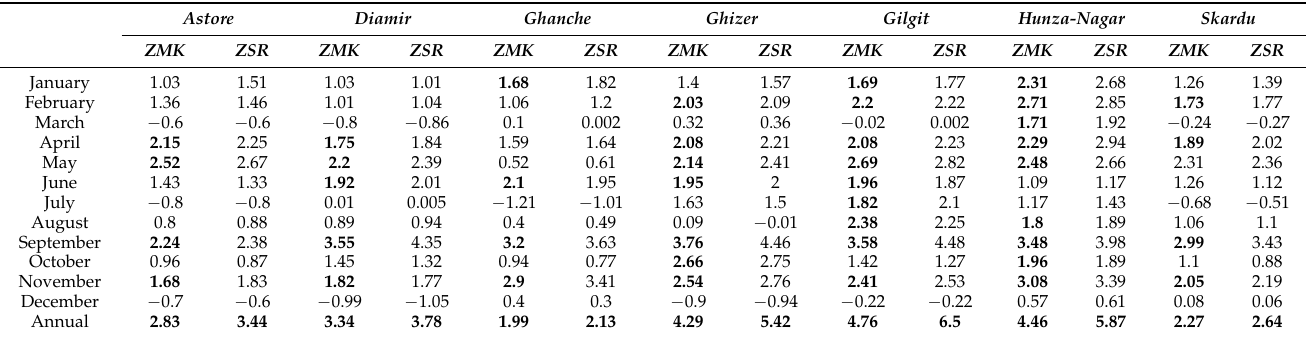
Table 6. SPI trend for 1 month and 12 months in Gilgit-Baltistan using MK and SR. Note: ZMK, Mann–Kendall; ZSR, Spearman’s